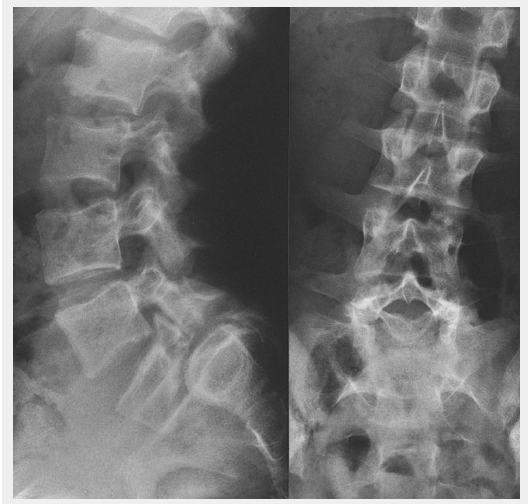
Figure 3 A 15-year-old female presenting with posterior thigh pain and an increasing stiffness. She shows a vertical sacrum, flattening of the thoracic and lumbar spine and an inability to round her back and to bend over. B Spondylolisthesis L5/S1 Meyerding grade IV with sacral rounding, umbosacral kyphosis and trapezoidal shape of vertebral body L5. Spondylolysis L5. In the ap. view there is a free sight into the spinal canal L5 due to the pathologic inclination of